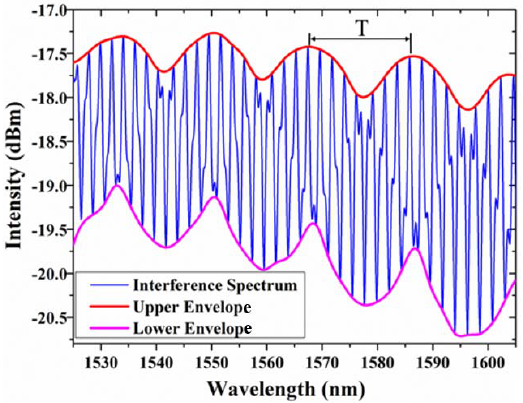
Figure 2. Interference spectrum of the proposed sensor with Vernier effect.